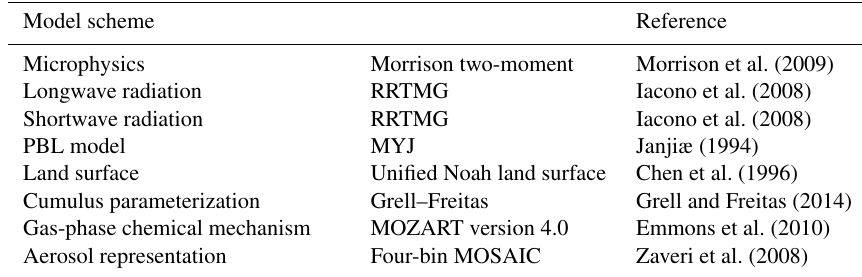
Table 3. Namelist settings of the physical parameterizations used in the WRF-Chem setup